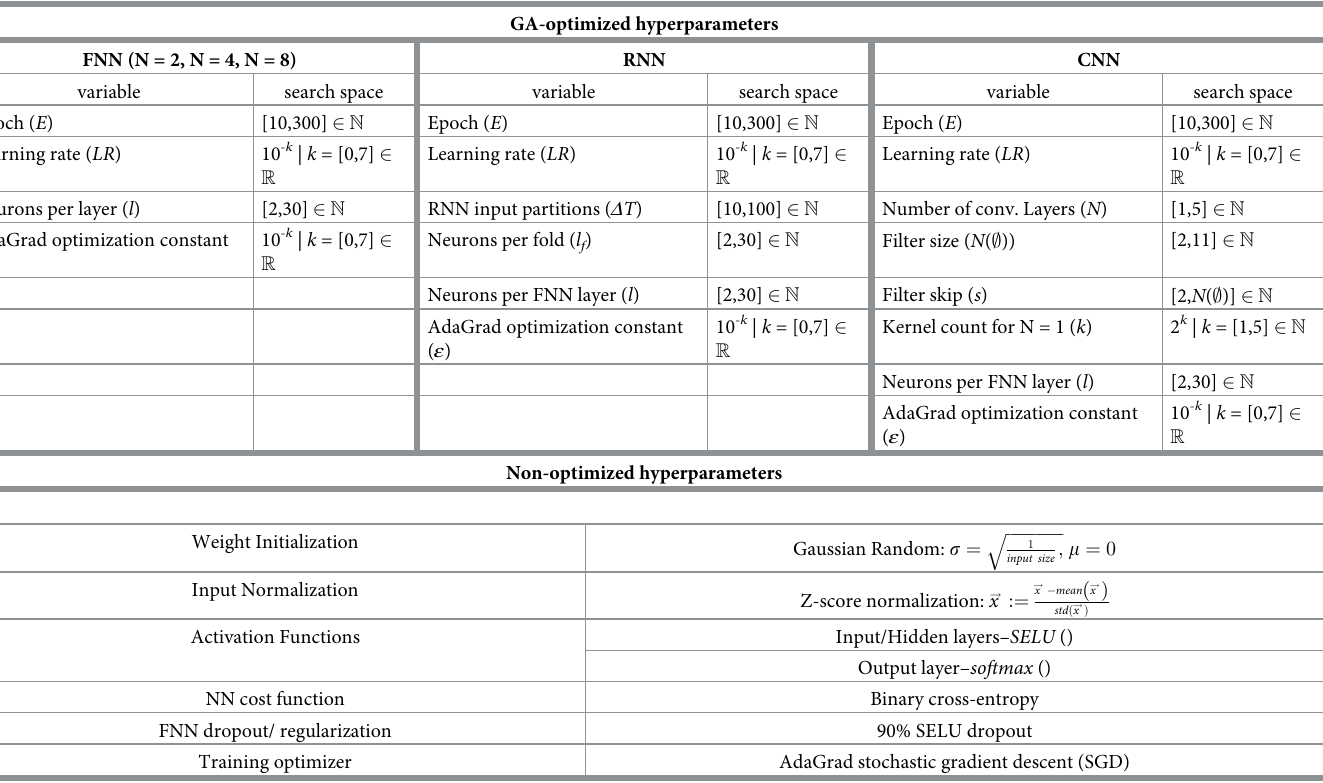
Table 1. Neural network hyperparameters for